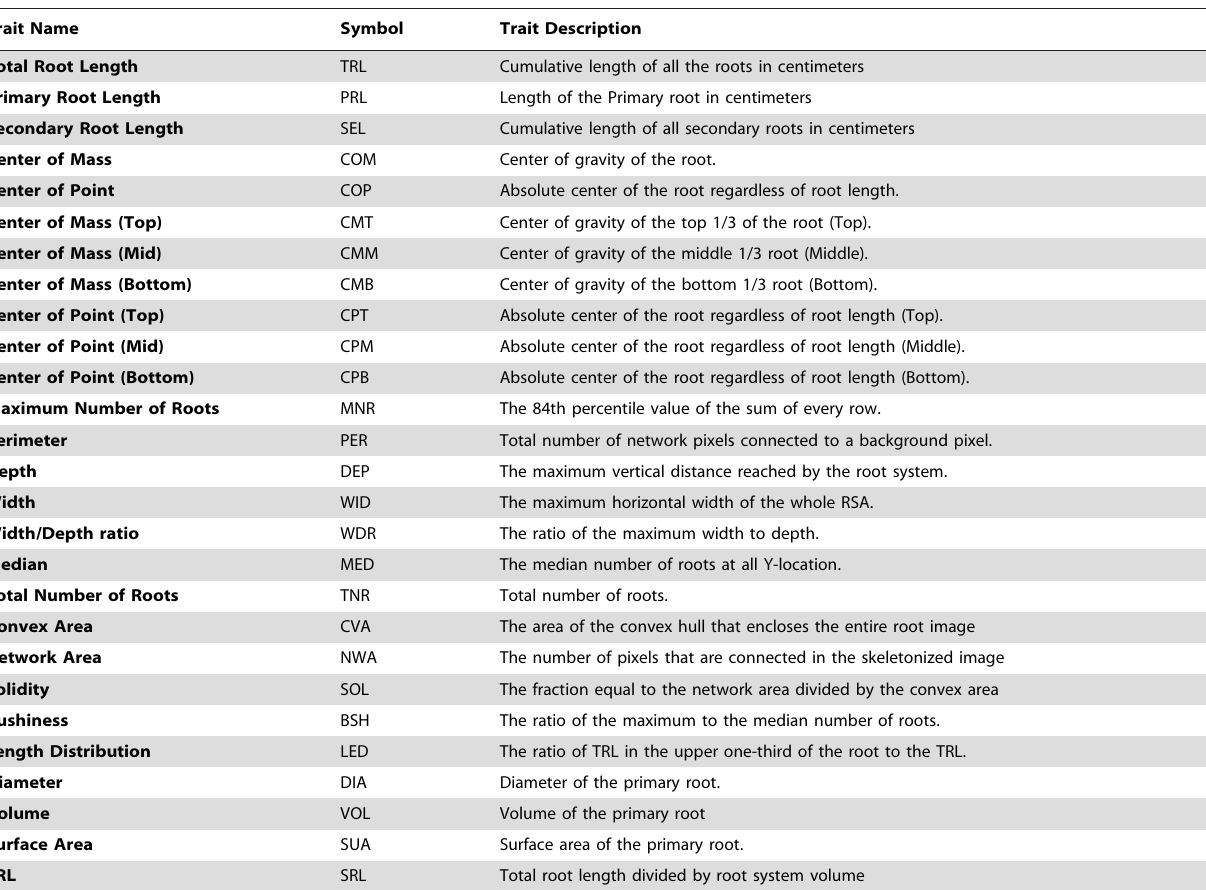
Table 1. Traits captured by